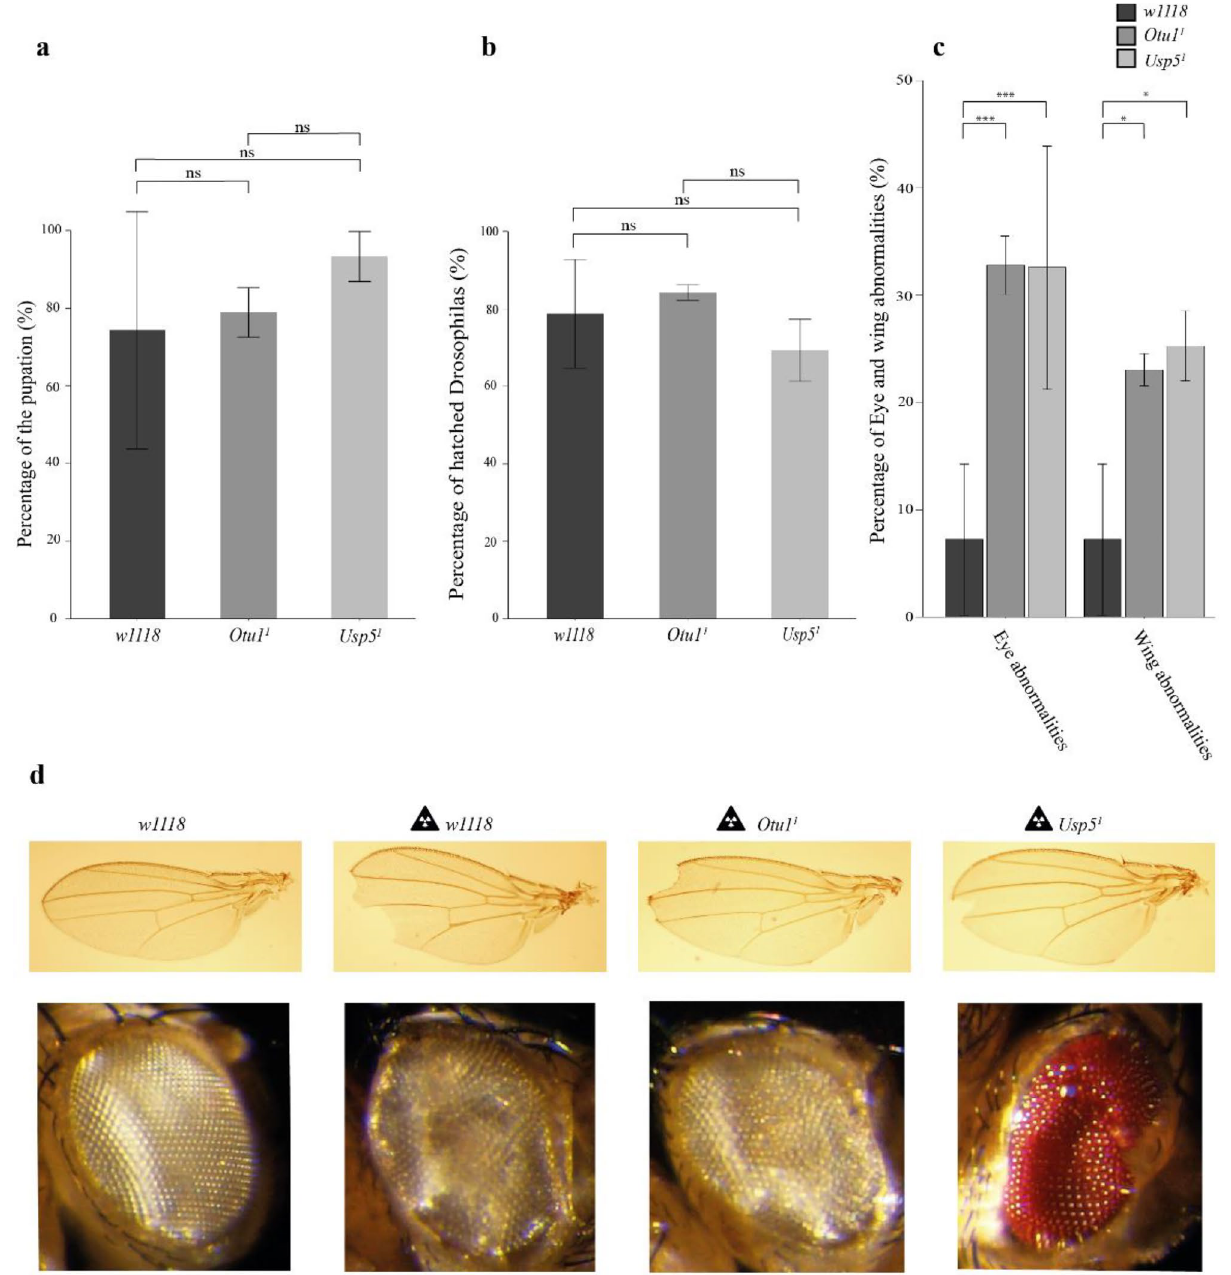
Figure 2. Effect of X-ray irradiation on the homozygous Otu1 1 (w + ; + ;CG4603 Δ101/2 /CG4603 Δ101/2 ) mutant and the heterozygous Usp5 1 mutant (w + ; + ;Usp5 1 /TM6b GFP ) Drosophila. ( a ) and ( b ) L3 DUB mutant larvae were irradiated with 40 Gy X-ray, and the rates of pupation and eclosion were measured ( a and b , respectively). ( c ) The percentage of wing and eye abnormalities was represented. In both the mutants and the control lines, the number of Drosophila with abnormale eye and wing phenotype was compared to the number of the hatched Drosophila which survived the X-ray treatment. ( d ) The detected wing and eye defects in adult DUB mutants are depicted. For the statistical analysis, one-way ANOVA in combination with Tukey’s post-hoc test was used. Significant values are indicated as follows: *P < 0.05, ***P < 0.001, ****P < 0.0001. Data were obtained from three independent